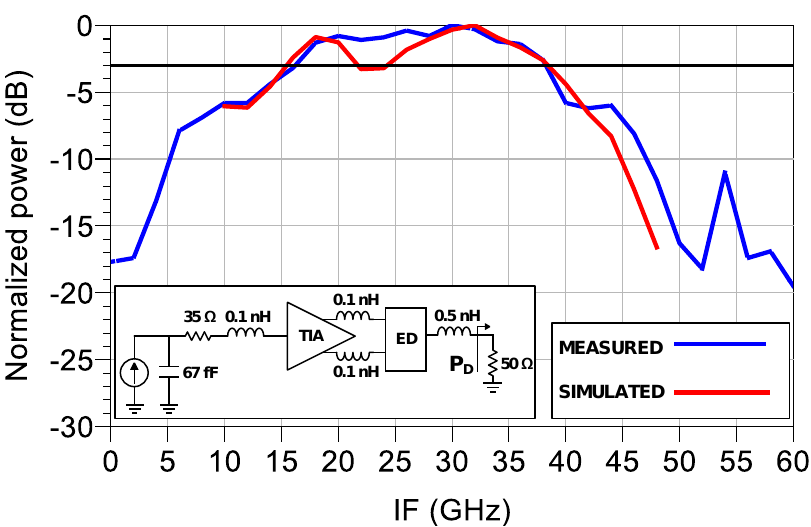
Figure 12. Measured and simulated opto-electrical bandwidth of the receiver using a 3 Gbps NRZ data transmission with swept IF center frequency. The inset shows a schematic representation of the simulation setup.